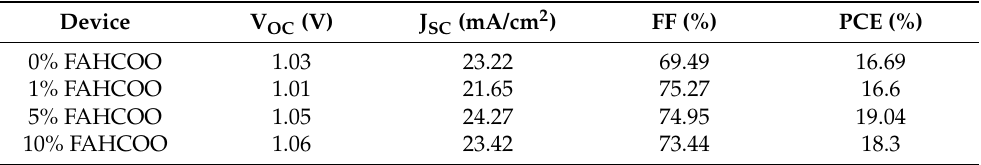
Table 1. Photoelectric performance parameters of the best-efficiency FAPbI 3 devices prepared with different addition amounts (0%, 1%, 5%, 10%) of